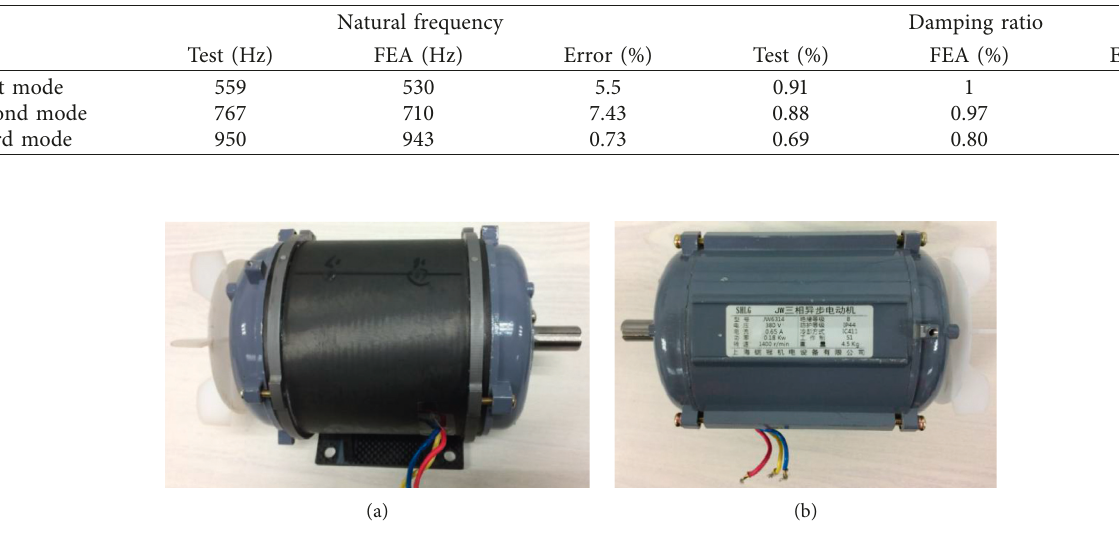
Figure 9: (a) Motor of CFRP frame. (b) JW6314 three-phase Asynchronous